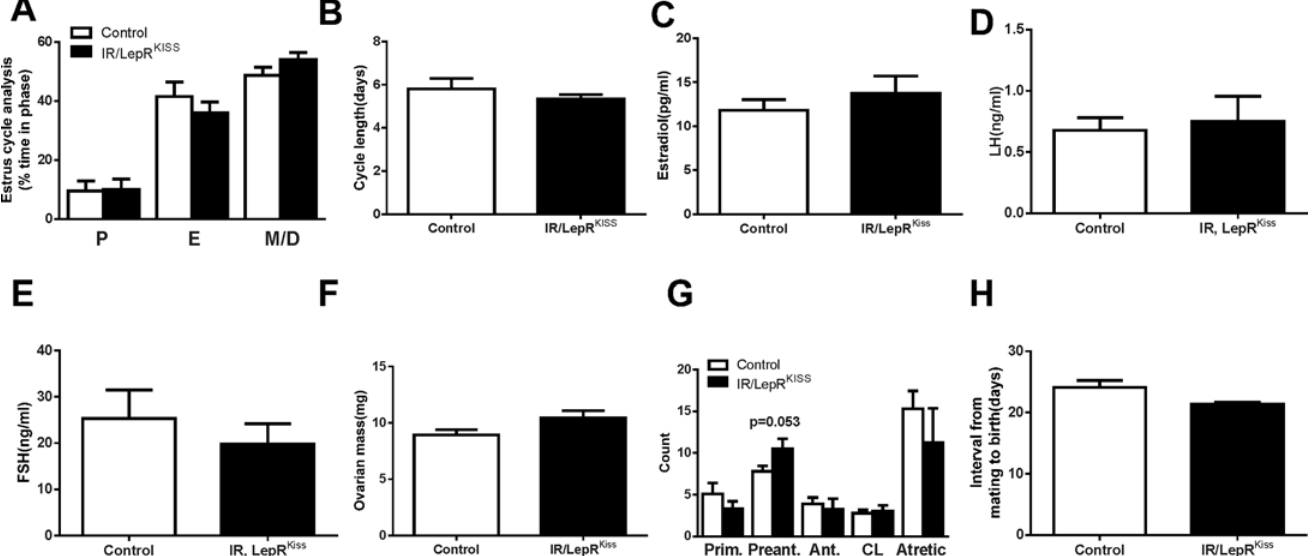
Fig 7. Female reproduction in IR/LepR Kiss mice. (A) Estrous cycle analysis (Control, n = 6; IR/LepR Kiss , n = 5) and (B) estrous cycle length (Control, n = 6; IR/LepR Kiss , n = 5) in 3 months old females. (C) Estradiol in adult females in control (n = 9) and IR/LepR Kiss (n = 6) mice. (D-E) LH and FSH levels in adult female control (n = 10) and IR/LepR Kiss (n = 16) mice. (F) Ovarian mass in adult females in control (n = 9) and IR/LepR Kiss (n = 6) mice. (G) Representative light photomicrographs of an adult IR/LepR Kiss mouse ovary (n = 4). CL, corpora lutea. Scale bar, 100 μ m. (H) Fertility data from 5 – 6 months old females paired with established male breeders. Interval from mating to birth of a litter and litter size were compared between control (n = 12) and IR/LepR Kiss (n = 6) mice. * P < 0.05.